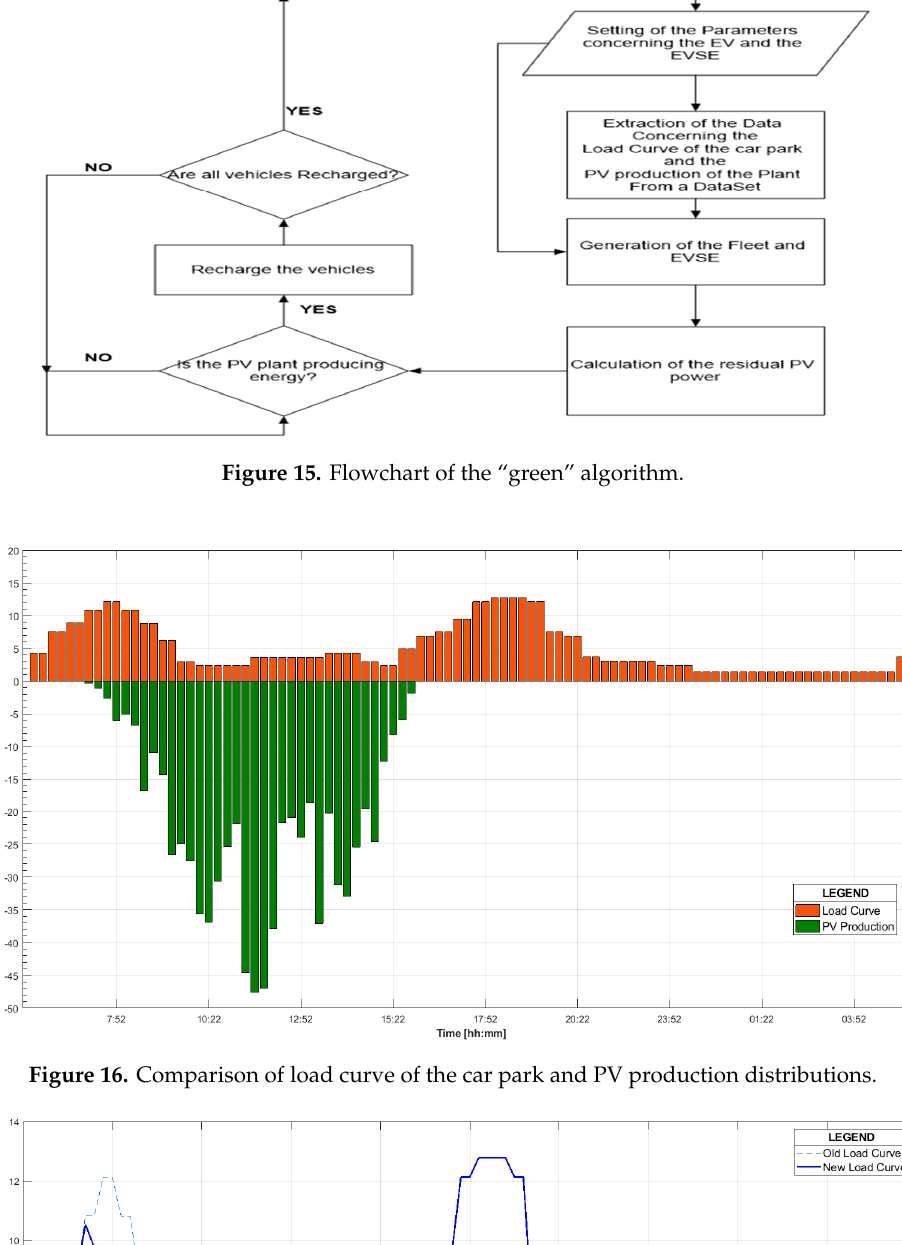
Figure 17. Comparison between the old load curve and the new one.